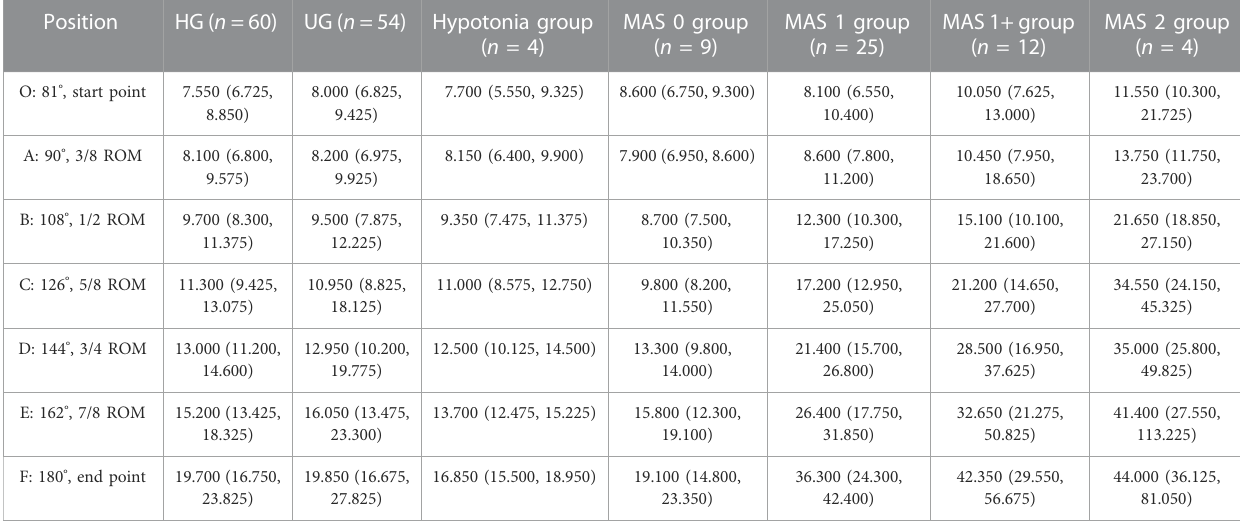
fi t the data. Each curve could obtain two parameters: curvature coef fi cient α and constant coef fi cient β . The fi tness of most participants ’ data to the exponential model was good. The adjusted R 2 of 59.5% of the data could reach more than 0.9, and 85.7% of them could reach more than 0.7. The data of